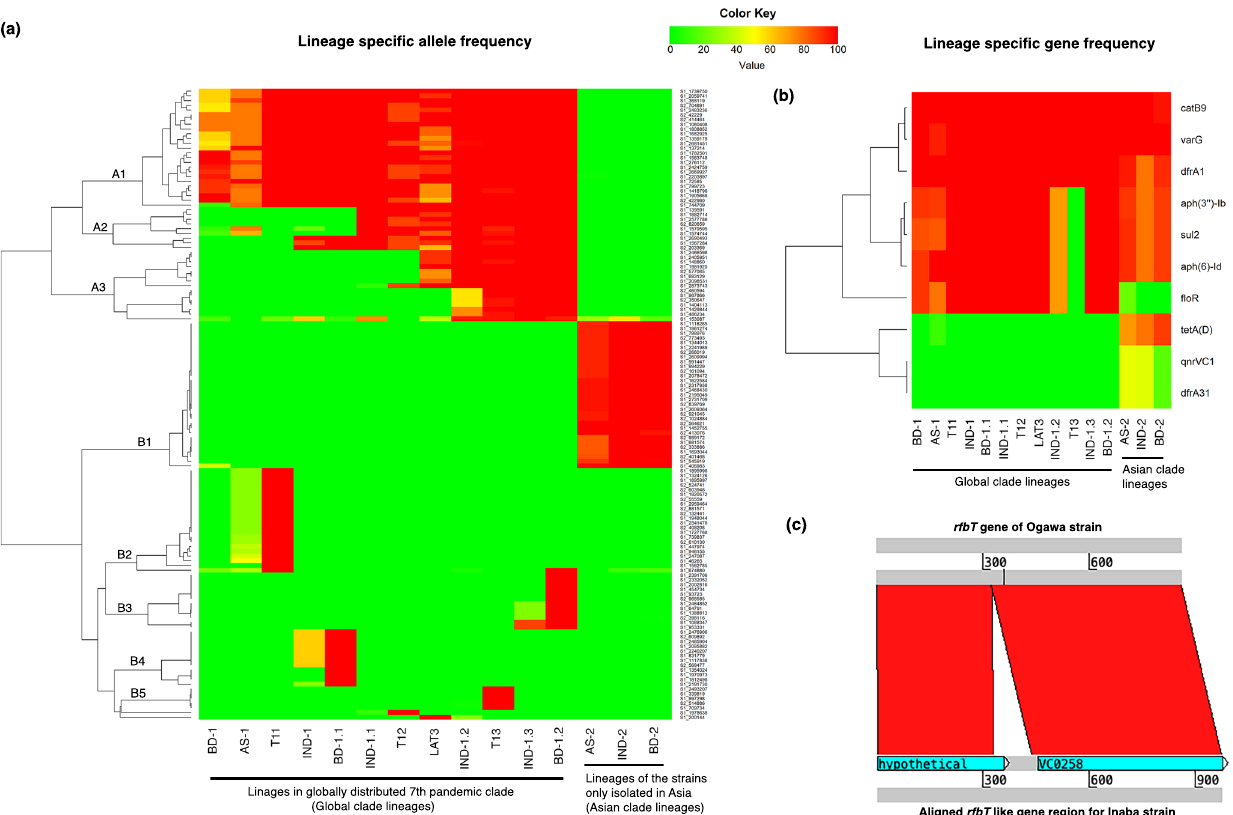
Fig. 3 | SNP clusters and AMR genes associated with lineages, and genetic changes in serotype switching. a Highly signi fi cant SNPs identi fi ed using chi- square test withtwo tailed p-valuesand plottedusing heatmapby clustering SNPs. X -axis shows the lineages/groups according to chronological order in the phylo- genetic tree, left y -axis showing SNP clusters and right y -axis ID of the lineage- associated SNPs. Frequency of the alternative allele of each lineage/group were plotted. BD-1, BD-1.1, BD-1.2, and BD-2 are lineages/groups of strains isolated from Bangladesh. IND-1, IND-1.2, IND-1.3, and IND-2 are lineages/groups of strains